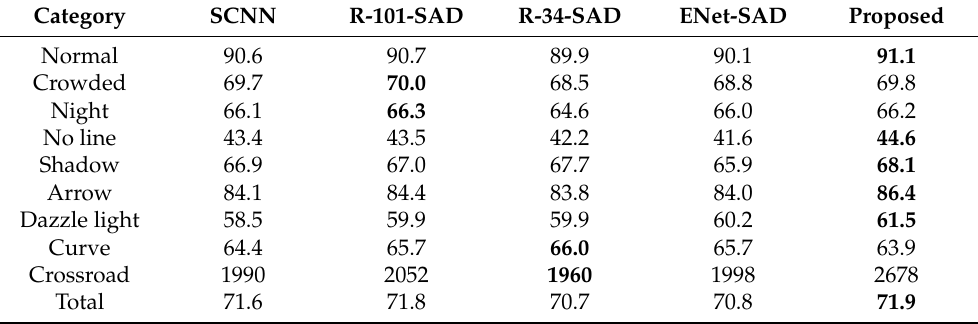
Table 8. Comparing the performances with different algorithms on CULane. We select an IoU threshold of 0.5 (F1 (0.5)) for this experiments. The FP is shown at the crossroads. Our experiment uses official evaluation metrics so that it can be compared fairly with other models. The bold scores are the